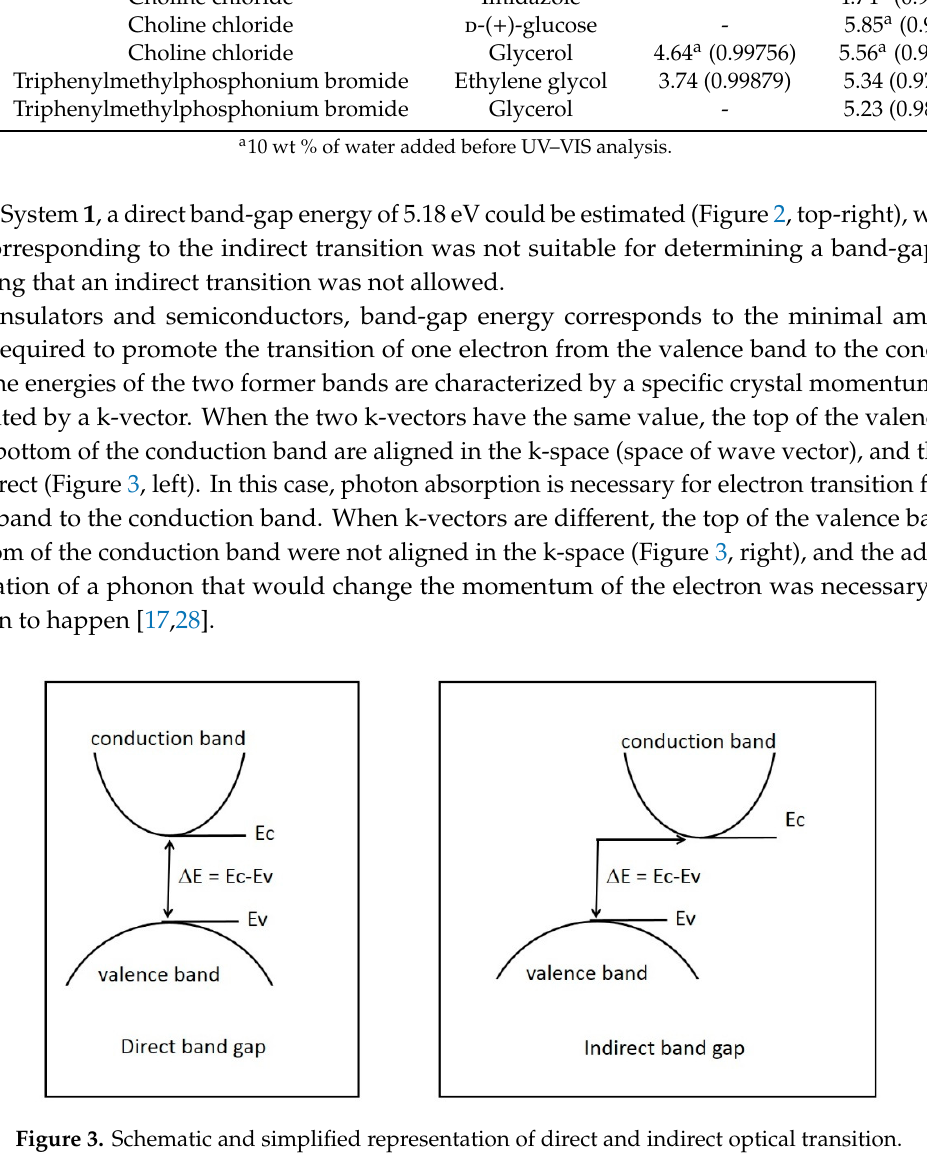
Figure 4. Tauc plots for (top) direct and (bottom) indirect transition of Systems (left) 2 , (center) 3 , and (right) 6.